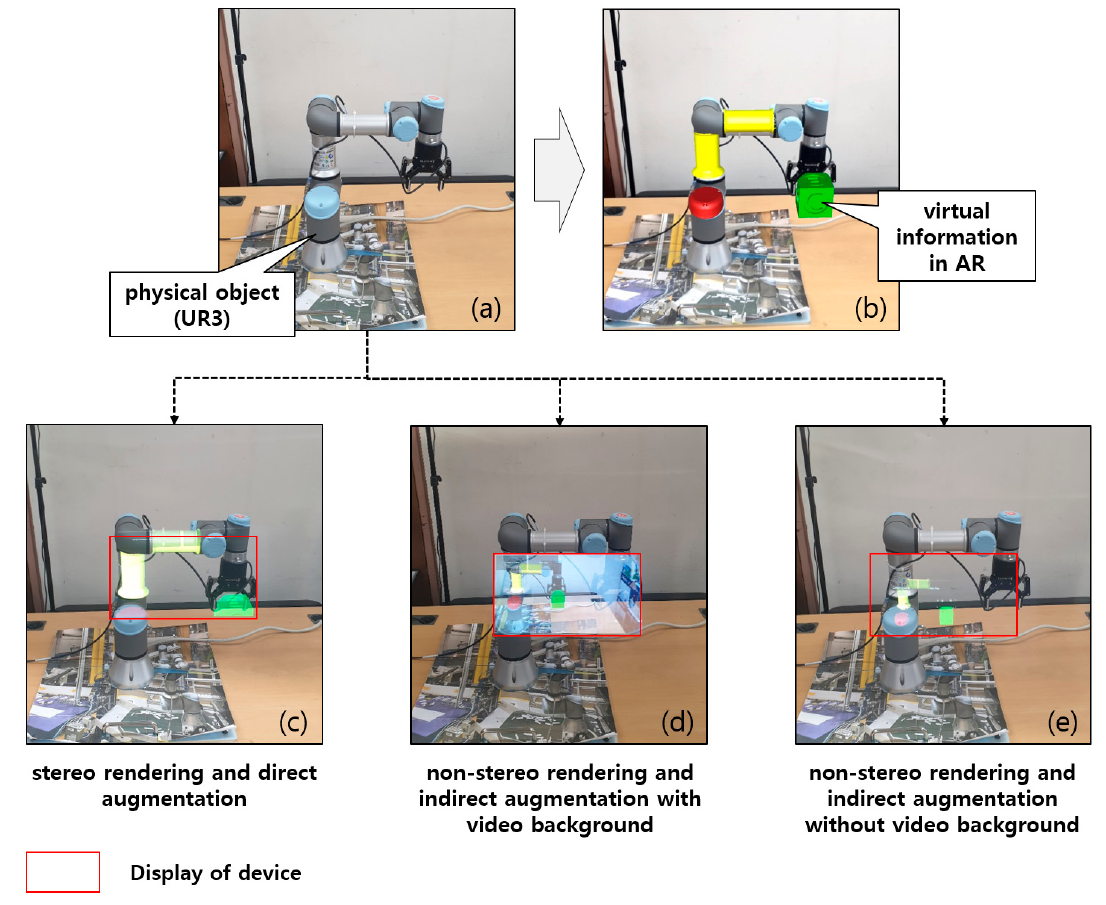
Figure 5. Visual augmentation depending on visual context in a real environment. UR3: Universal Robot-3.